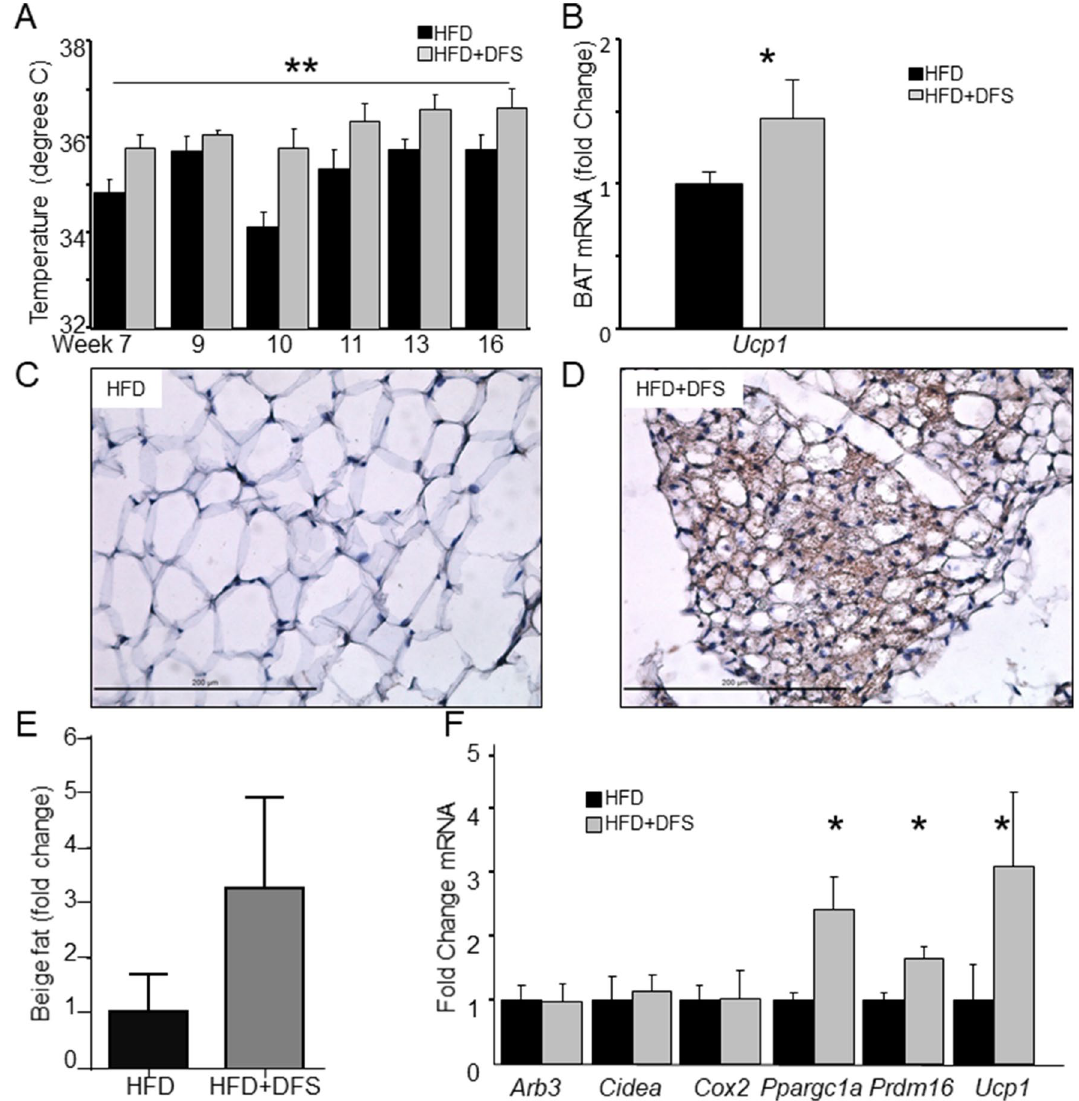
Figure 3. Deferasirox fed mice had increased beige fat. ( A ) Body temperature was higher in HFD + DFS mice (ANOVA for repeated measures). ( B ) In brown adipose tissue (BAT), Ucp1 mRNA was higher. ( C , D ) UCP1 immunostained inguinal fat from HFD-fed and HFD + DFS mice. Scale bars are 200 µm. ( E ) Areas of dense UCP1 staining were quantified. ( F ) Fat from HFD + DFS mice had increased expression of Ppargc1a, Prdm16 and Ucp1 mRNAs. *p < 0.05, **p < 0.01. Data is shown as mean ± SEM (standard error of the mean) unless otherwise (Fig. 4E) and quantified (Fig. 4F). Mice fed HFD + DFS had larger adipocyte size than chow-fed mice, and HFD had the largest adipocyte size. Deferasirox increases energy expenditure in inguinal fat explants.